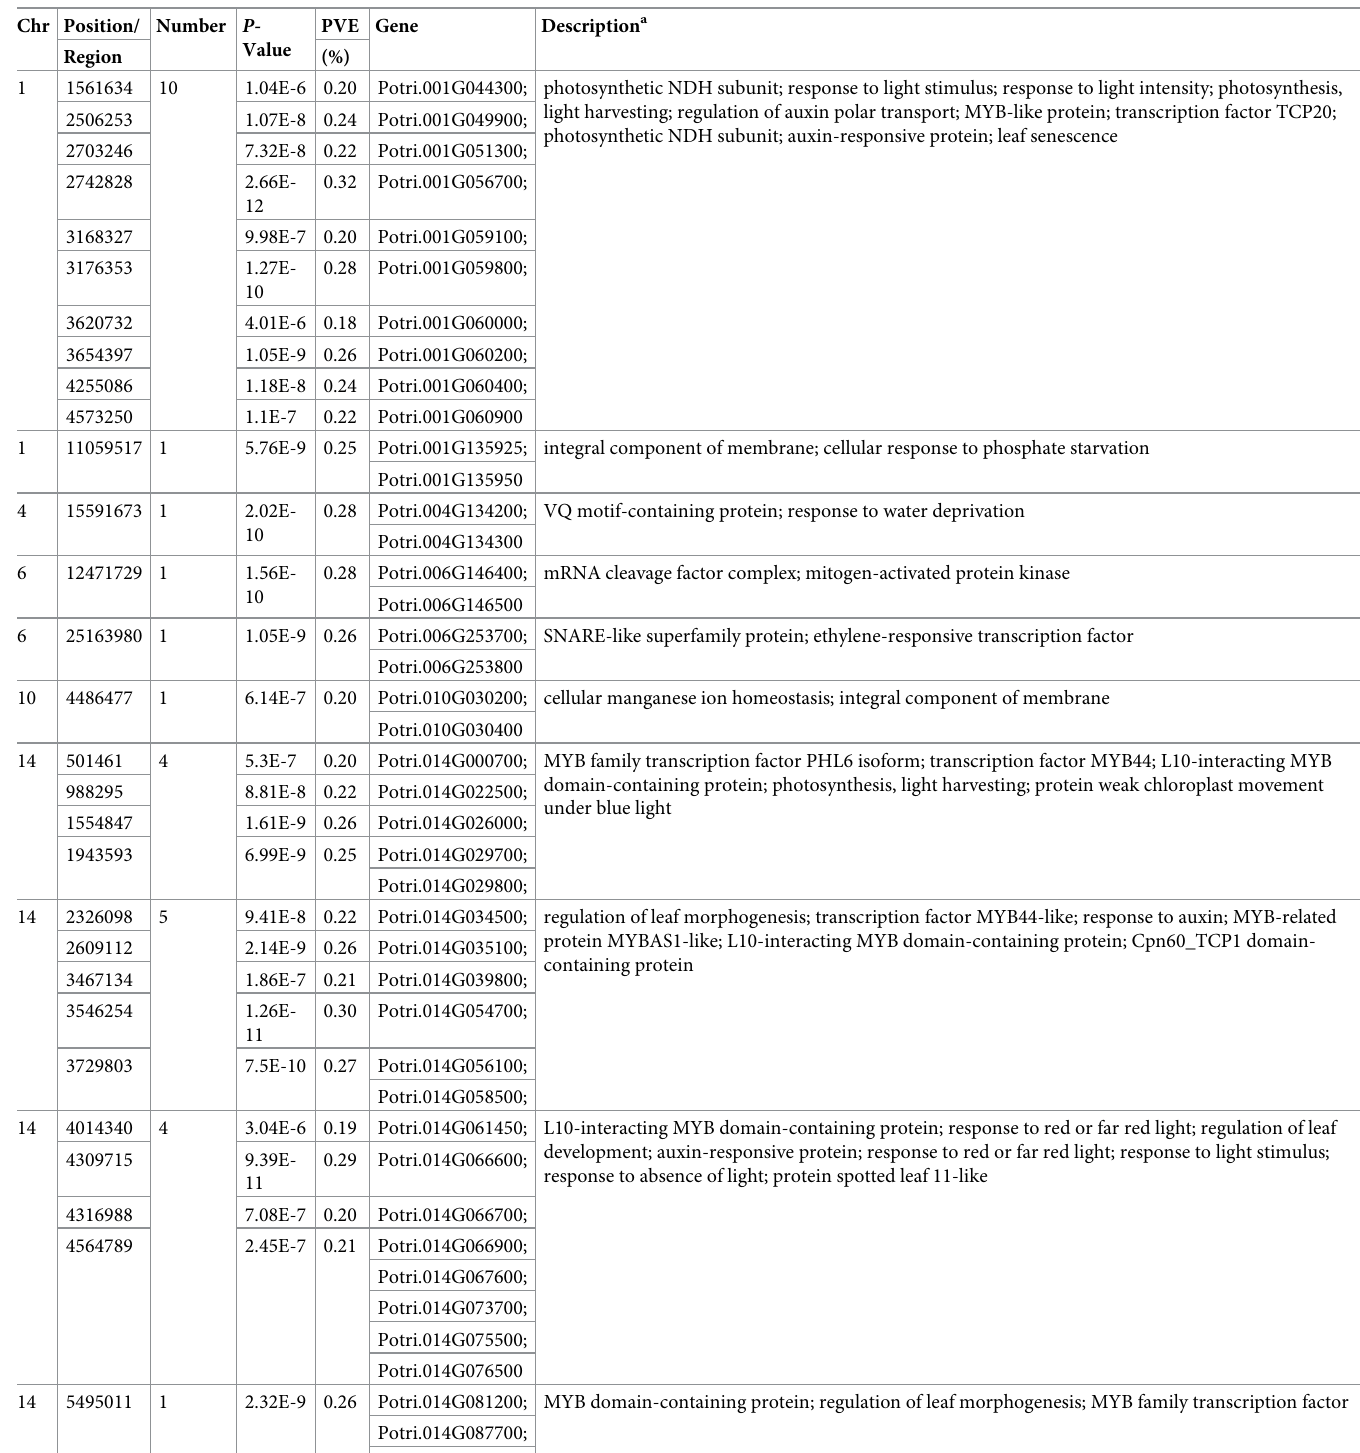
Table 3. Summary of the significant SNPs associated with the leaf shape represented by the multiple trait dataset